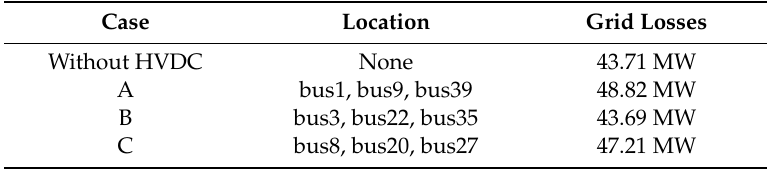
Table 3. Grid losses with di ff erent HVDC